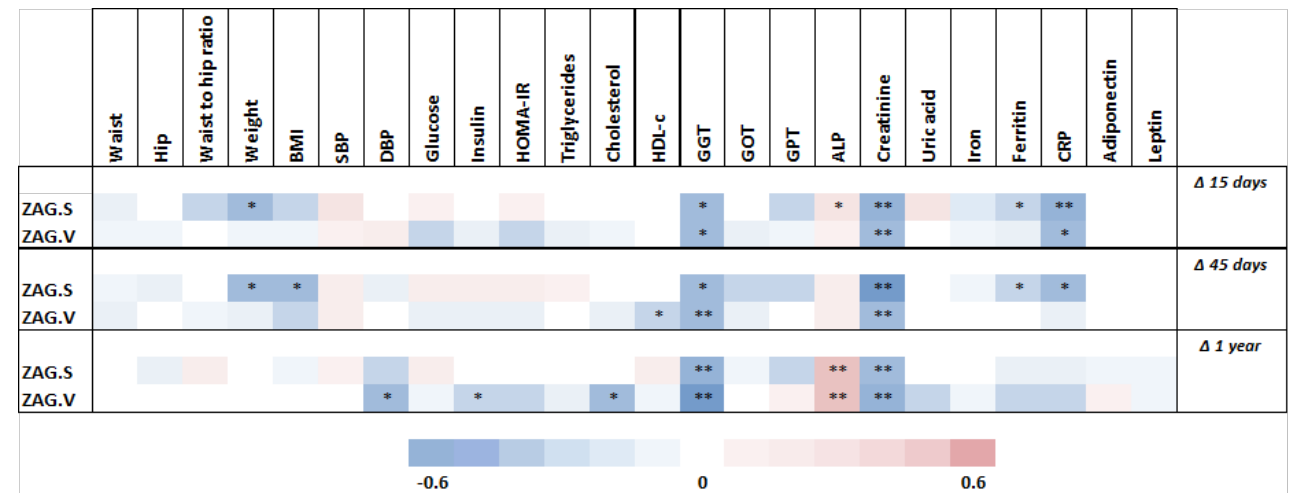
Figure 3. Correlations between clinical and biochemical parameter changes after surgery and basal adipose tissue ZAG levels. Abbreviations: ∆ , percentage decrease ((initial value − final value)/initial value)*100; ALP, alkaline phosphatase; BMI, body mass index; CRP, c reactive protein; DBP, diastolic blood pressure; GGT, gamma-glutamyl transferase; GOT, glutamic oxaloacetic transaminase; GPT, glutamic pyruvic transaminase; HDL-c, high-density lipoprotein cholesterol; HOMA-IR, homeostasis model assessment of insulin resistance; SBP, systolic blood pressure; WHR, waist to hip ratio; ZAG.S; subcutaneous adipose tissue ZAG; ZAG.V; visceral adipose tissue ZAG. Statistical significance is expressed as: * p < 0.05; ** p < 0.01.